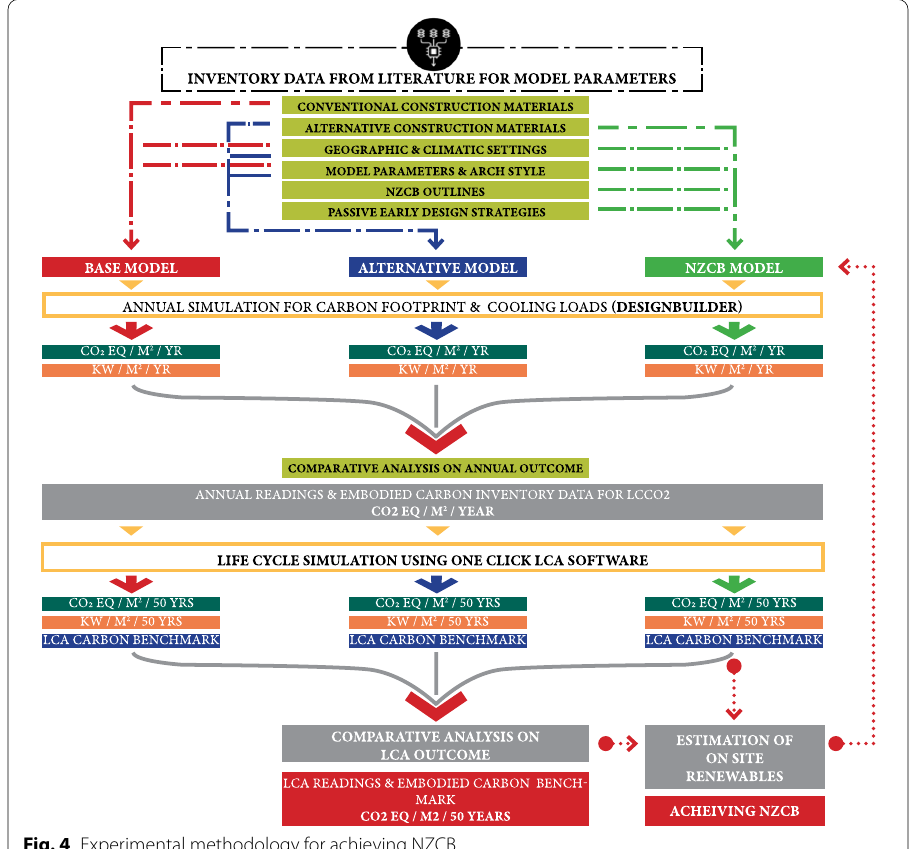
Fig. 4 Experimental methodology for achieving